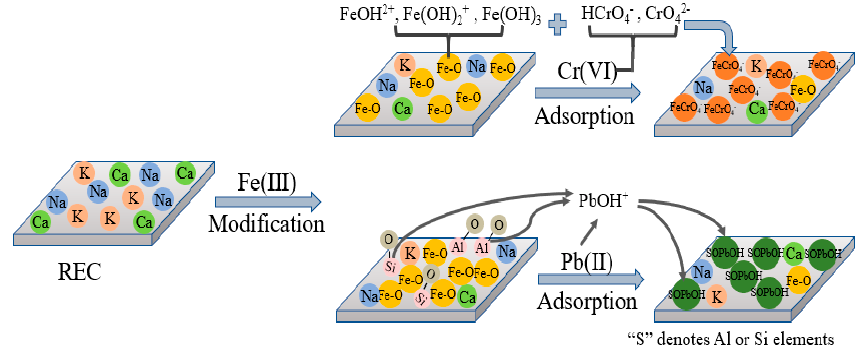
Figure 13. Schematic diagram of REC modification and Cr(VI) and Pb(II) adsorption.